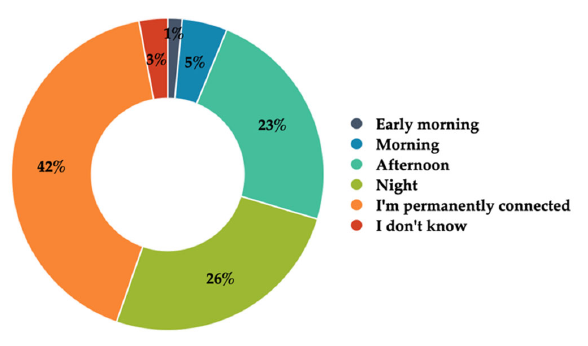
Figure 2. Period of the day when you spend the most time connected in a row.